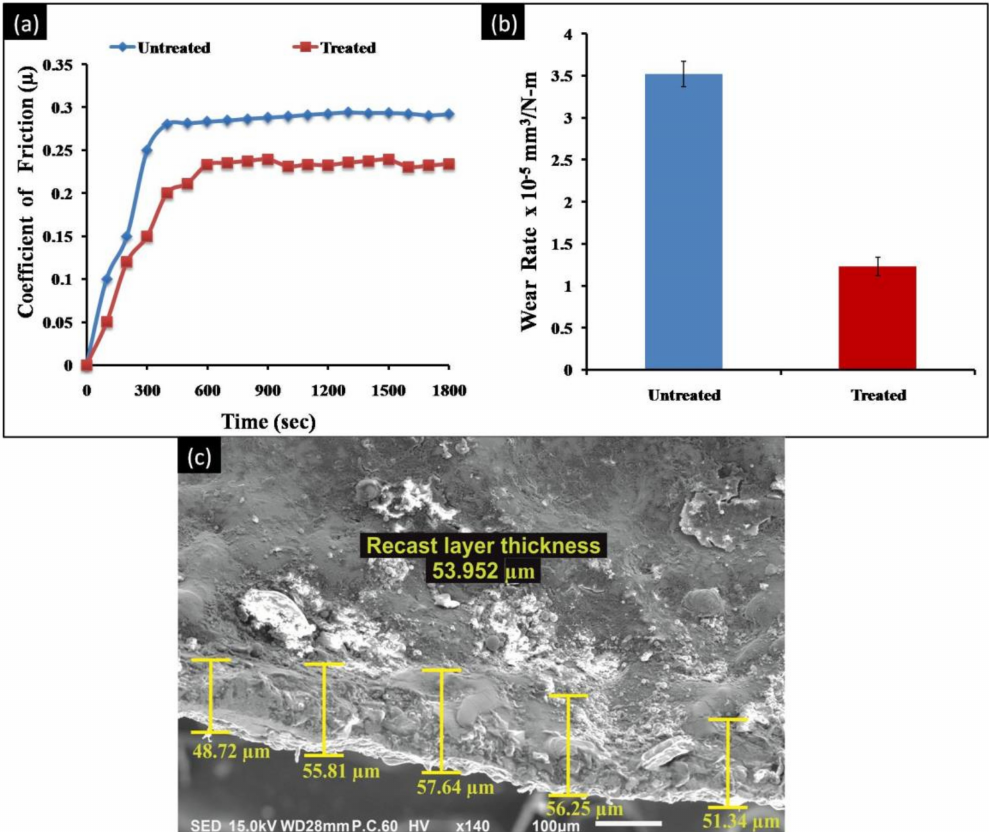
Figure 6. ( a ) Wear rate comparison of untreated and treated samples; ( b ) Variation of the co-e ffi cient of friction of samples; ( c ) Cross-section of the EDMed substrate.